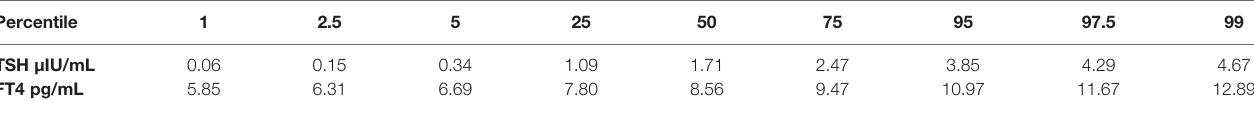
TABLE 1 | Thyroid hormone levels by percentiles in the population studied in gestation week 8 ± 1.